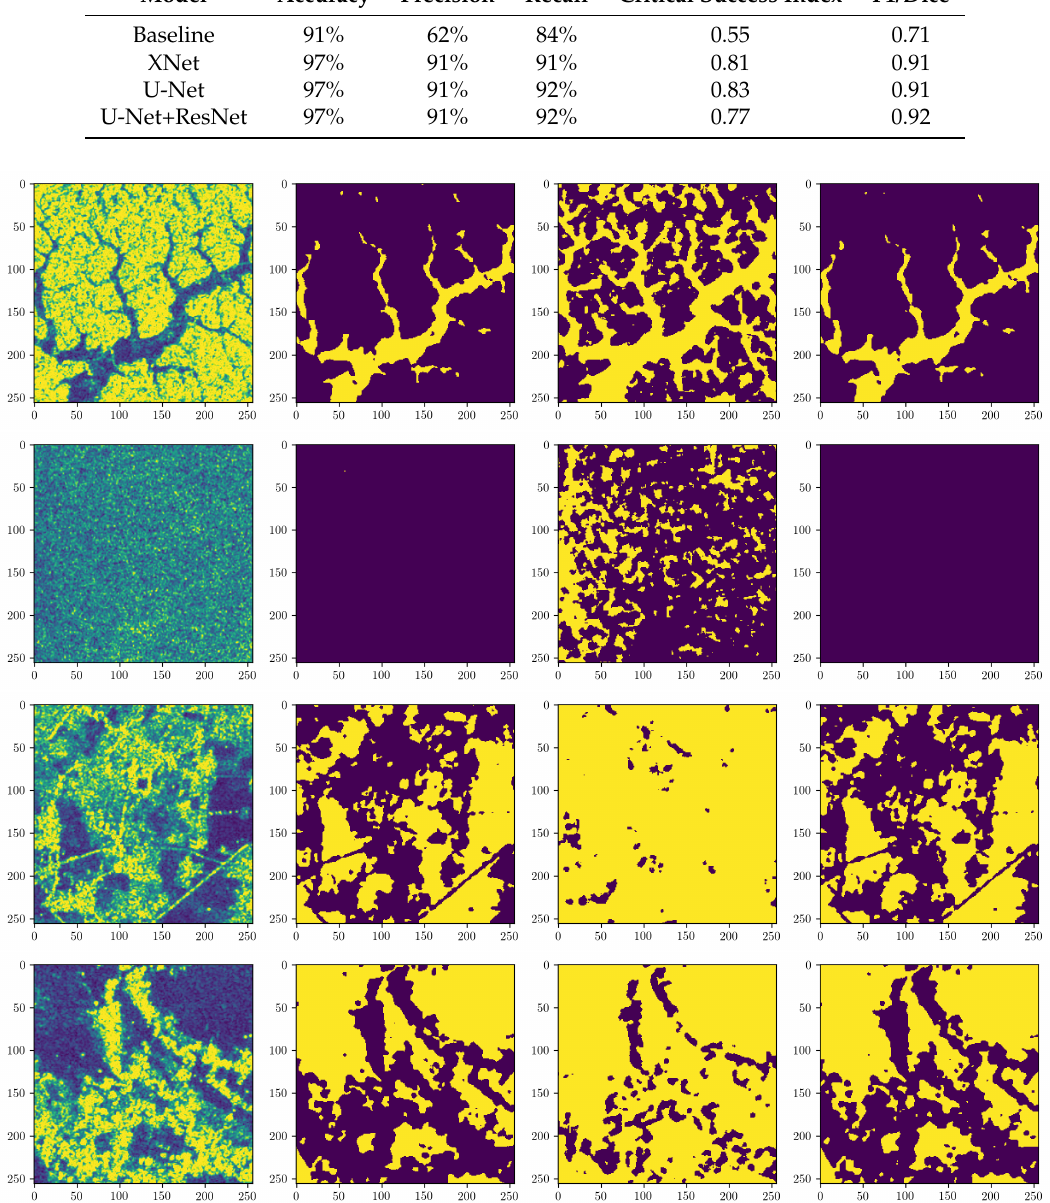
Figure 10. From left to right: raw SAR tiles displayed using the viridis colormap followed by tiles of different analyses corresponding to classical histogram based, baseline and neural network predictions. The background is displayed in purple and flood in